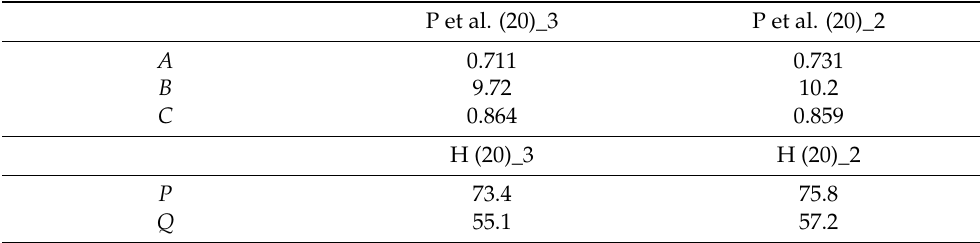
Table 3. Least-square best-fit parameters of Equations (2) and (3) in Silty Loam.